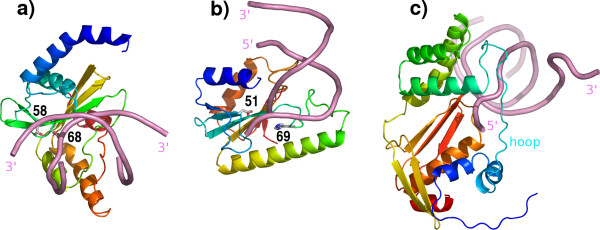
Comparison of modes of DNA binding to superimposed nuclease(-like) domains. The domain structures are those of a) PvuII (PDB code 1pvi; [22] b) vsr exonuclease (PDB code 1odg; [23]) and c) RecC (PDB code 1w36; [18]). Protein chains are coloured in a spectrum from blue (N-terminus) to red (C-terminus) while DNA is coloured uniformly pink. In order to illustrate the approximate locations of the catalytic sites, selected catalytic residues are shown for PvuII (D58 and E58) and vsr exonuclease (D51 and H69). DNA termini are labelled, as is the "hoop" in RecC.